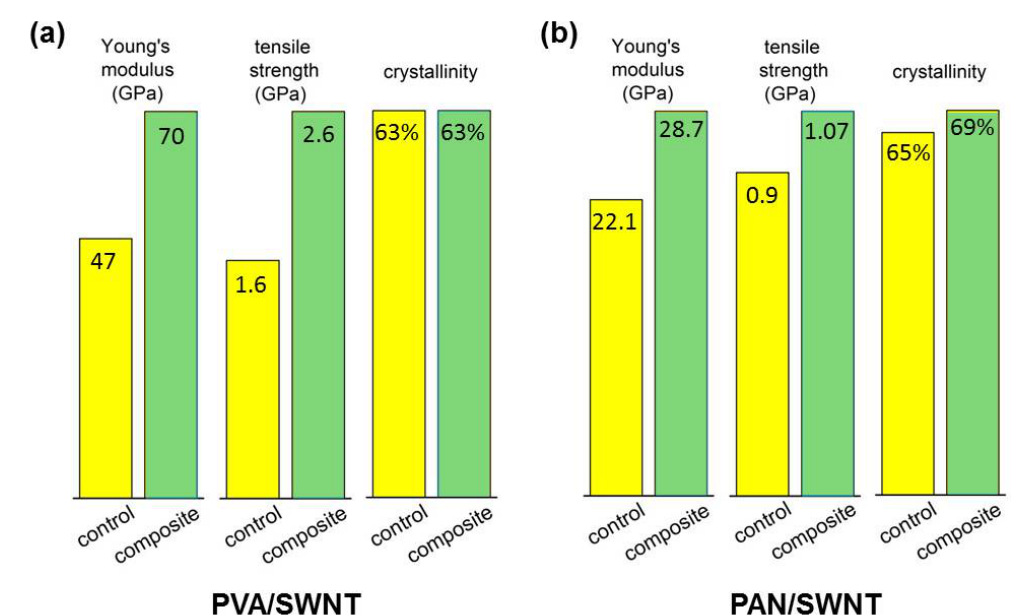
Figure 9. Comparison of mechanical property improvement for ( a ) poly(vinyl alcohol) PVA/CNT and ( b ) polyacrylonitrile (PAN)/CNT fibers, which display SWNT-templated polymer extended-chain crystallization and orientation